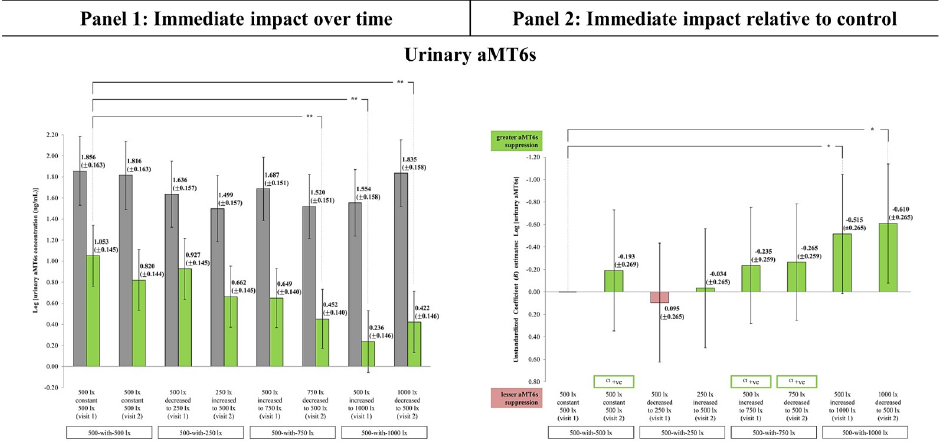
Fig 5. The immediate impact observed in Urinary aMT6s across the light-settings. (Panel 1) Immediate change over time in all light-settings: Bars represent Estimated Marginal Means (EMM) with Standard Errors (SE); whiskers 95% confidence interval (CI); ��� p < 0.001, �� p < 0.01, � p < 0.05, ^ p < 0.06. Dark grey bar specifies EMM at TP 1 . Green bar specifies EMM at TP 2 (supportive change). (Panel 2) Immediate impact of each light-setting relative to control: Bars represent Unstandardized Coefficient ( B ) with Standard Errors (SE); whiskers 95% CI; ��� p < 0.001, �� p < 0.01, � p < 0.05, ^ p < 0.06. Green bar specifies light-setting as more supportive than control. Red bar specifies light-setting as less supportive than control. (S2 Fig) The chronological order of each light-setting’s EMM Δ for urinary aMT6s. It is recommended to be referred along with Fig 5 to improve the comprehension between panel 1 and 2. Light-setting with EMM Δ chronologically ordered above than the control (S2 Fig) corresponds with the direction of the B estimate bar as being more supportive than control (Fig 5, panel